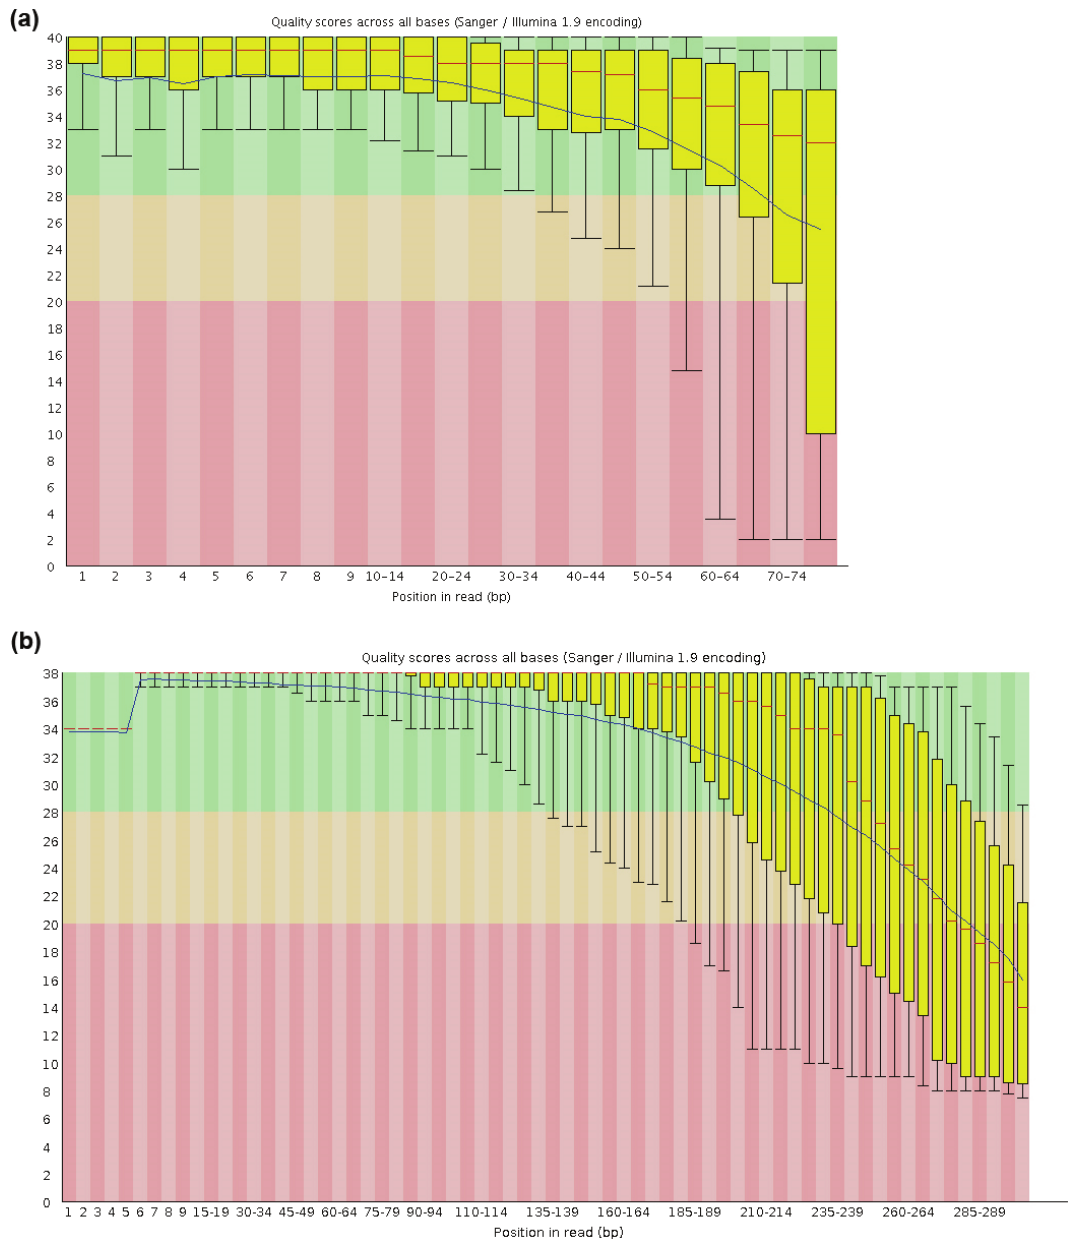
Figure A1. Per base sequence quality of capture sequencing of B95-8 EBV on Genome Analyzer IIx 76 bp protocol ( a ) and MiSeq 300 bp protocol ( b ). These quality profiles are representative of other samples in the same run.